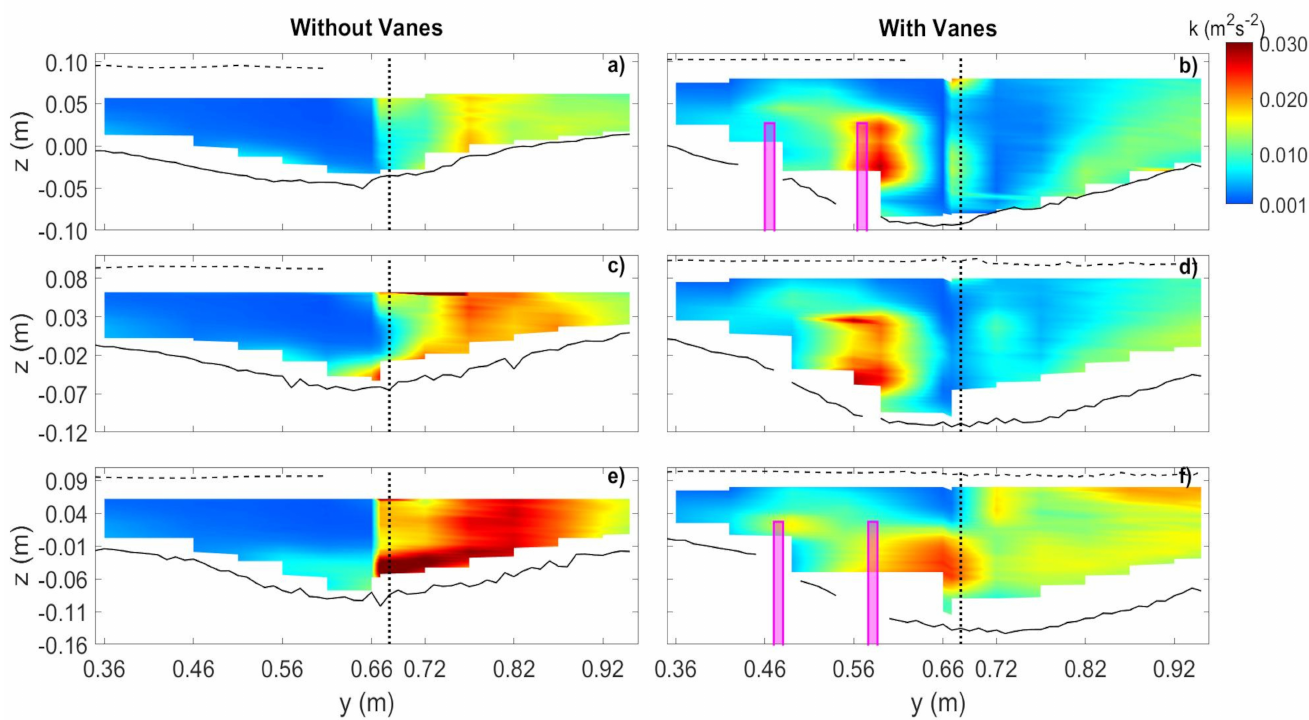
Figure 18. Turbulent kinetic energy k (m 2 · s − 2 ) as color scale, in the NV and the VF experiments, in the inner half of the main channel and part of the diversion channel, at cross-sections: ( a ) x = 0.08 m. ( b ) x = 0.08 m. ( c ) x = 0.13 m. ( d ) x = 0.13 m. ( e ) x = 0.18 m. ( f ) x = 0.18